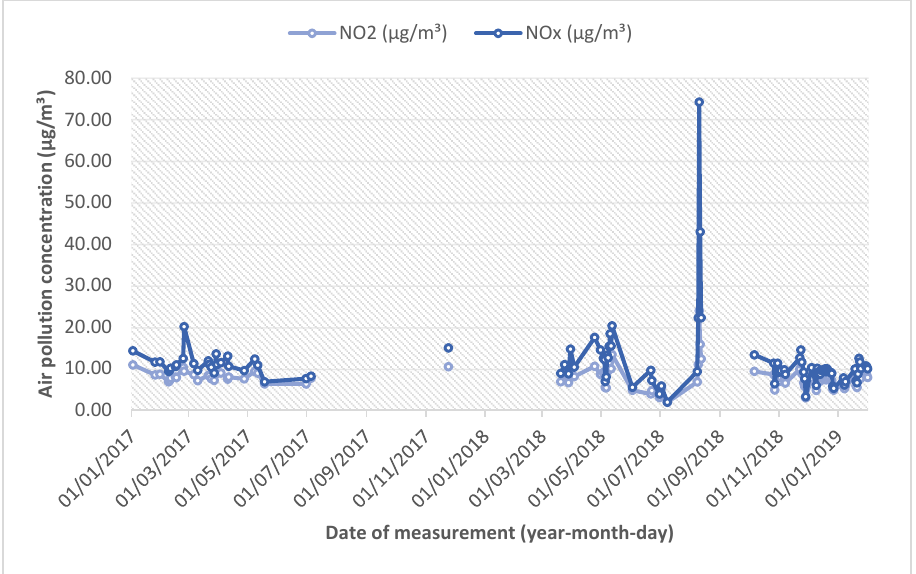
Figure 4. Yearly concentrations of NO 2 and NO x in Adama City.